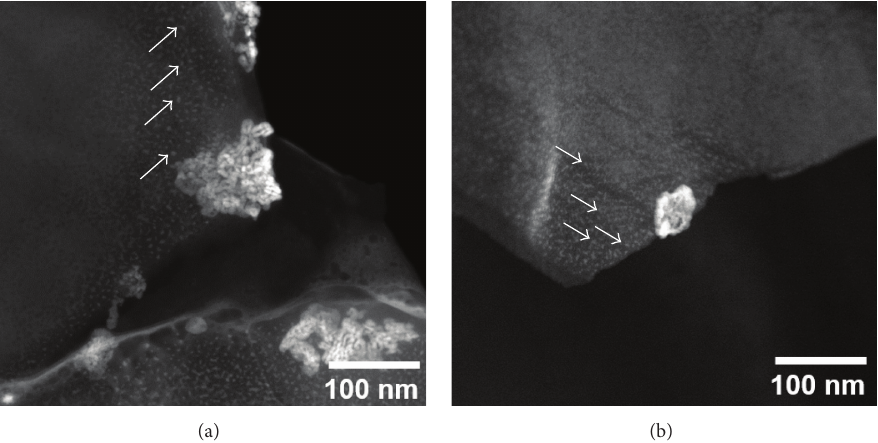
Figure 12: (a) Dark field TEM image of an AR sample (small, widely distributed white dots in the size of approximately 4 nm are GP-zones). (b) Dark field TEM image of a DCT sample (small, widely distributed white dots in the size of approximately 4 nm are